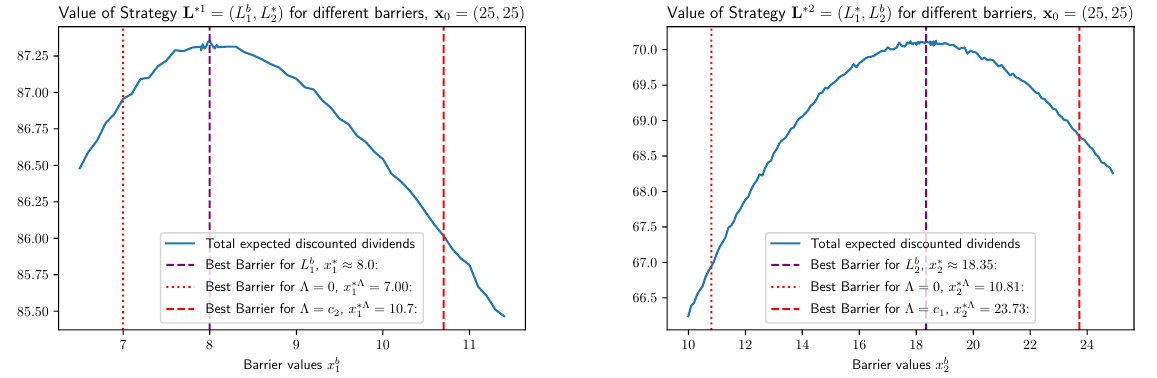
) and L ∗ 2 = ( L ∗ , L ∗ 2 1